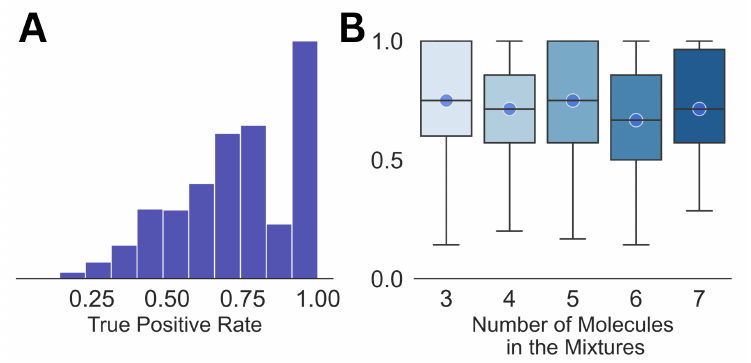
Figure 1. The distribution of the true positive rates for the entire dataset ( A ) and against the size of the mixture ( B ) is shown. The circles in ( B ) emphasize the median for each of the